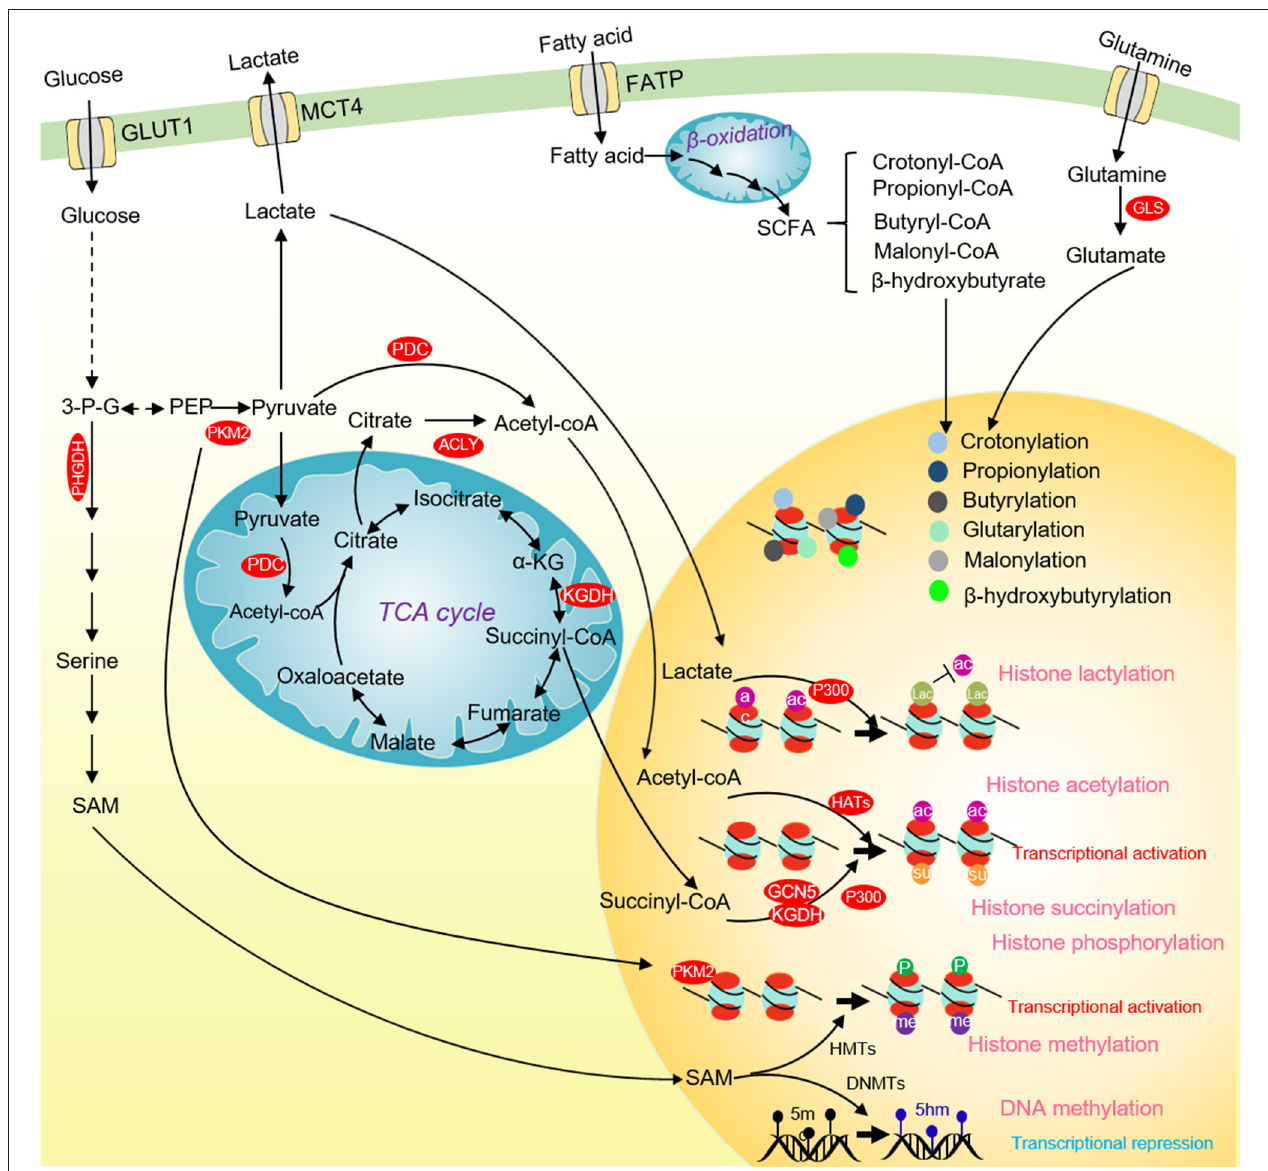
FIGURE 4 | Glucose metabolism and chromatin modifications in cancer cells. ACLY and PDC contribute to nuclear acetyl-CoA production and subsequent histone acetylation and gene activation. Glucose-derived serine and one-carbon metabolism are accelerated in cancer cells to produce SAM. SAM not only enhances DNA methylation to repress the transcription of tumor suppressor genes, but also activates the transcription of tumor-promoting genes by methylating histones. Nuclear PKM2 phosphorylates STAT3 to activate CCND1 transcription and promote cell cycle progression. The TCA cycle intermediate succinate-CoA is fueled to histone succinylation by succinyltransferase ( α -KGDH, GCN5, and p300) to activate gene transcription. p300 uses lactate as a substrate to catalyze the lactylation of multiple histone lysine residues to inhibit histone acetylation. Some short-chain fatty acids produced by β -oxidation of fatty acids can provide substrates for histone crotonylation, propionylation, butyrylation, β -hydroxyisobutyrylation, glutarylation and malonylation. ACLY, ATP-citrate lyase; PKM2, pyruvate kinase M2; α -KG, α -ketoglutarate; SCFAs, short-chain fatty acids; 3-P-G, 3-phosphoglycerate; SAM, S-adenosyl methionine; HMTs, Histone methyltransferases; DNMTs, DNA methyltransferases; GCN5, general control non-derepressible 5; p300, histone acetyltransferase p300.